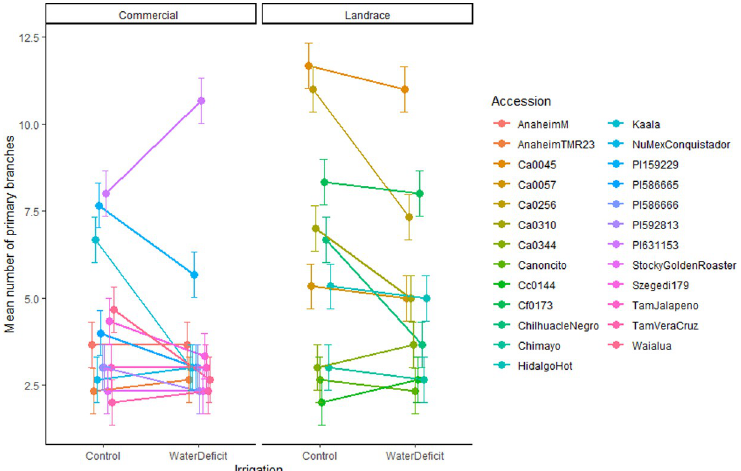
Fig 1. Interaction of irrigation and accession means with standard error bars for primary branch number in a greenhouse soil water deficit experiment on chile pepper ( Capsicum sp.) at the Ohio State University. Accessions are separated by domestication level.